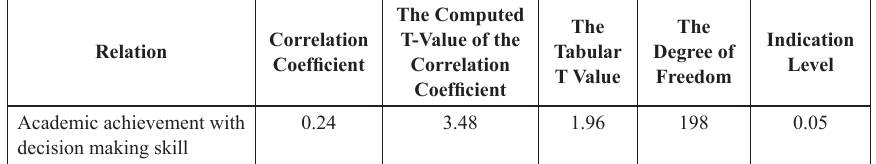
Table 7. Correlation coefficients between decision-making skill & academic achievement and the significance of correlation when at research sample The Computed The The Correlation T-Value of the Indication Relation Tabular Degree of Coefficient Correlation Level T Value Freedom Coefficient